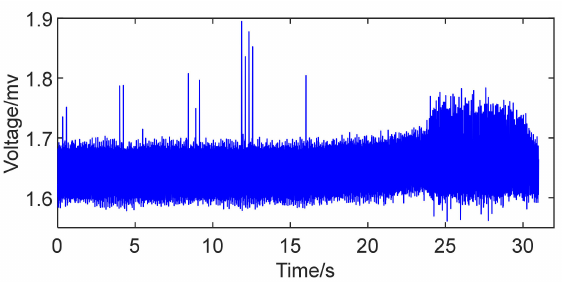
Figure 2. Original output voltage signal diagram at measuring point #1.